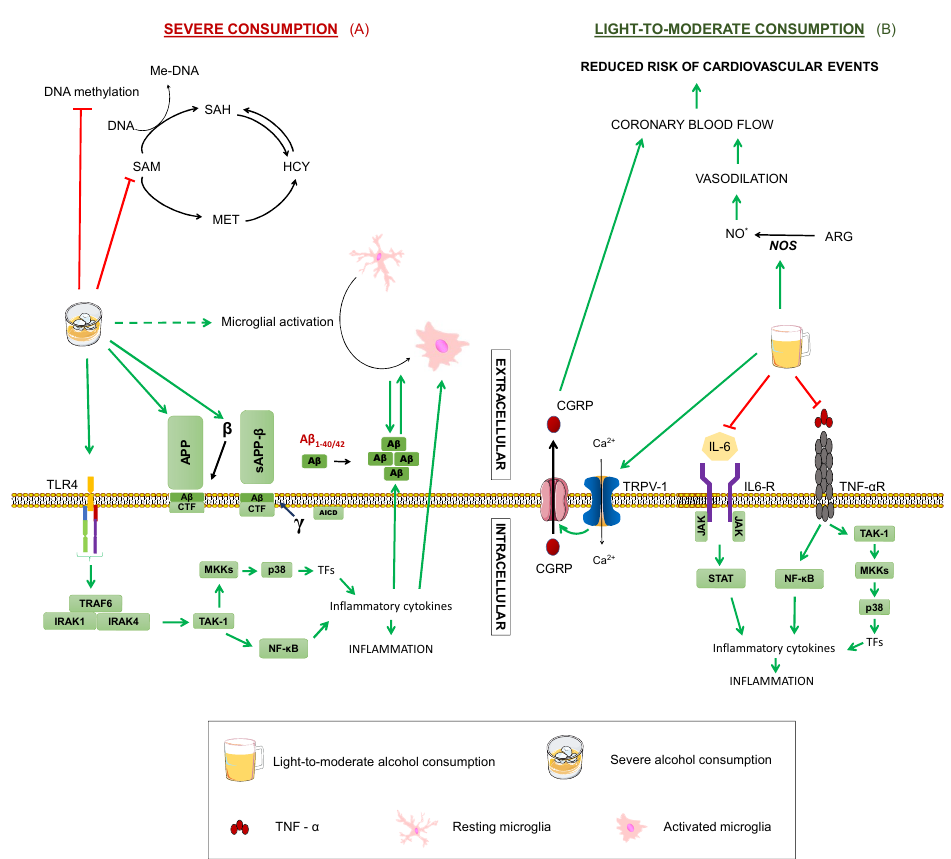
Figure 7. Effects of alcohol on Alzheimer’s disease. Summary of the processes by which alcohol may modulate Alzheimer’s disease in ( A ) severe consumption and ( B ) light-to-moderate: Tumour Necrosis Factor α . TNF- α R: TNF α receptor. IL-6: interleukin-6. TAK1: transforming growth factor beta-activated kinase 1. NF- κ B: nuclear factor kappa-light-chain-enhancer of activated B cells. P38: P38 mitogen-activated protein kinases. MKK4: Mitogen-Activated Protein Kinase Kinase 4. TRAF6: TNF receptor associated factor 6. IRAK1: Interleukin-1 receptor-associated kinase 1. IRAK4: Interleukin-1 receptor-associated kinase 4. APP: amyloid-beta precursor protein. sAPP α : soluble α -APP. sAPP β : soluble β -APP. CTF: carboxy-terminal fragment. AICD: APP intracellular domain. MET: methionine. SAM: S-adenosylmethionine. SAH: S-adenosylhomocysteine. HCY: homocysteine. THF: tetrahydrofolate. 5-MTHF: 5-methyltetrahydrofolate. Me-DNA: methylated-DNA. ARG: arginine. NO: nitric oxide. TRPV-1: transient receptor potential cation channel family V (vanilloid) member 1. CGRP: Calcitonin gene-related peptide. TNF α Green arrows represent activation. Dashed green arrows show indirect activation. Red truncated arrows represent